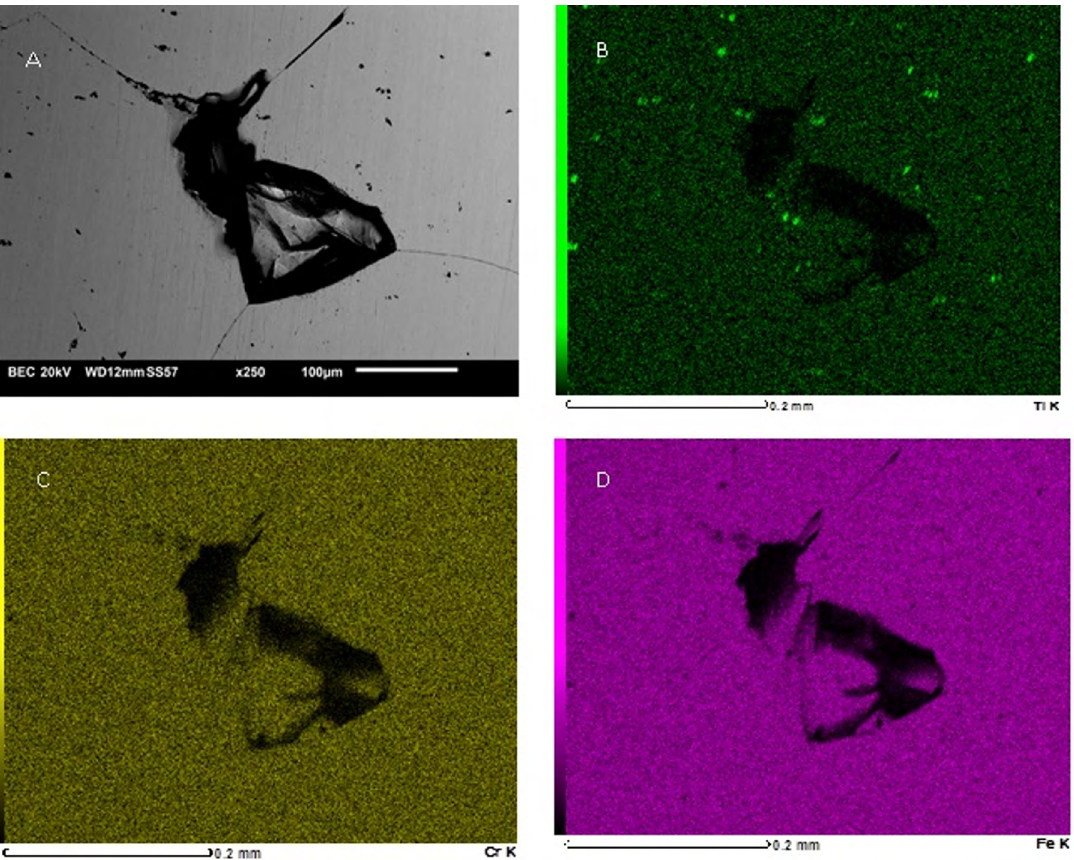
Figure 14. a) SEM micrograph of the AISI 409 stainless steel after potentiostatic polarization, showing a pit at grain boundaries intersections and dark small Ti-rich precipitates; EDS elemental mapping for: b) Ti; c) Cr and d) Fe. potentiostatic polarization in 0.1 M NaCl solution at